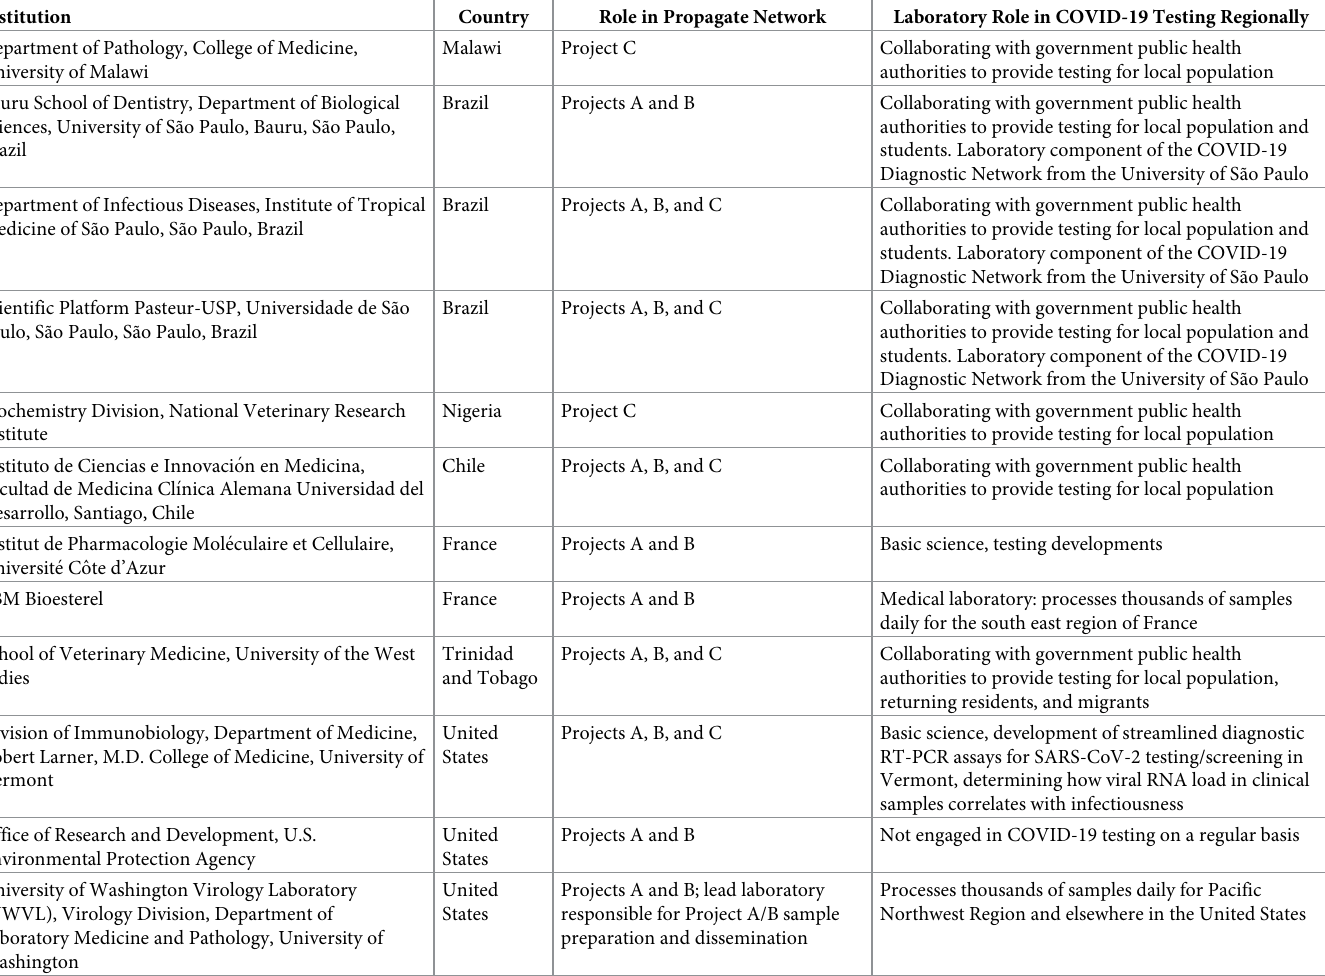
Table 1. Institutions and countries of the laboratories participating in the